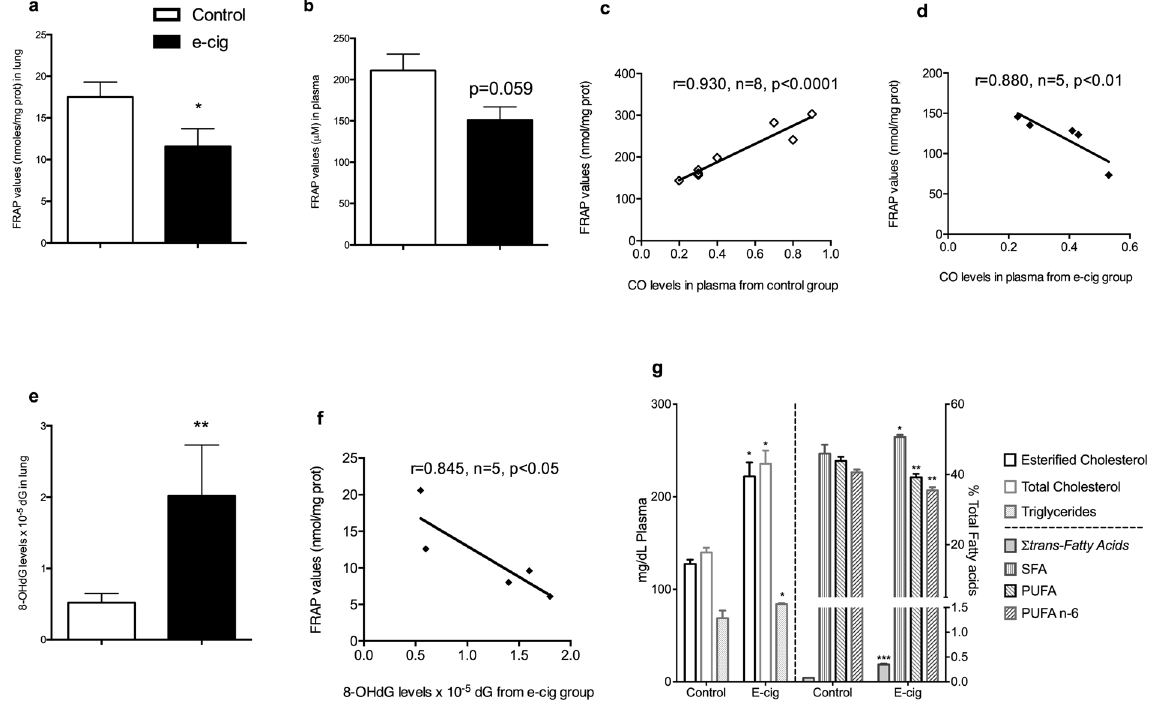
Figure 2. Systemic antioxidant capacity, oxidative DNA damage and lipidomics. ( a ) FRAP lung, loss > 33% ( P < 0.05). ( b ) FRAP plasma ( P = 0.059). ( c ) FRAP plasma from e-cig group inversely correlated vs CO (r = 0.930, P < 0.001). ( d ) FRAP plasma from control group positively correlated vs CO (r = 0.880, P < 0.01). ( e ) 8-OHdG lung levels markedly increased ~288% ( P < 0.01). ( f ) FRAP lung from e-cig group inversely correlated vs 8-OHdG (r = 0.845, P < 0.05). Data (n = 5 measurements per group) are expressed as means ± standard error of the mean (SEM), analysed by one-way analysis of variance (ANOVA) ( g ) left side , content of esterified cholesterol, total cholesterol and triglycerides (mg/dL) determined by GC/MS and GC/FID for qualitative and quantitative analysis, respectively, on Control and E-cig groups. Right side , sum of C18:1 trans isomers, saturated fatty acids (SFA), polyunsaturated fatty acids (PUFA) and PUFA n-6 series (PUFA n-6) in percentage (%) of total fatty acids determined by GC/FID on Control and E-cig groups. Each bar represents the means ± S.D. of ten measurements performed on ten * P < 0.05, ** P < 0.01, *** P < 0.001, two-tailed t